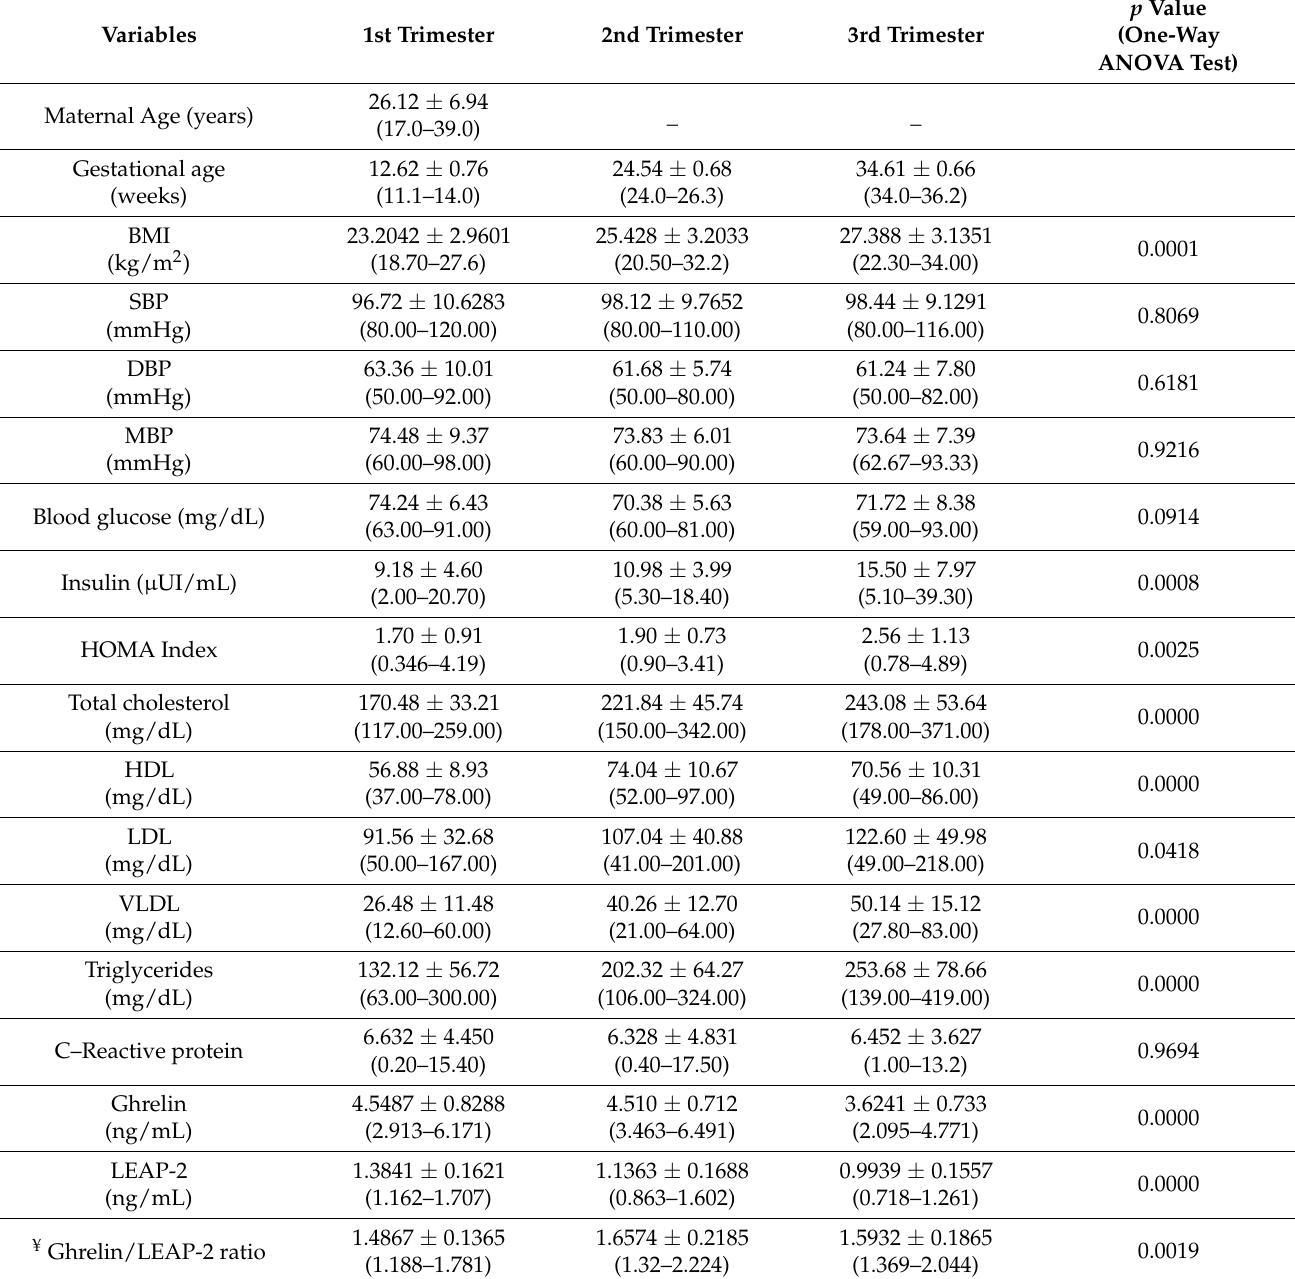
Table 1. Characteristic of healthy normotensive pregnant women during the 1st trimester, 2nd trimester and 3rd trimester of pregnancy (n =